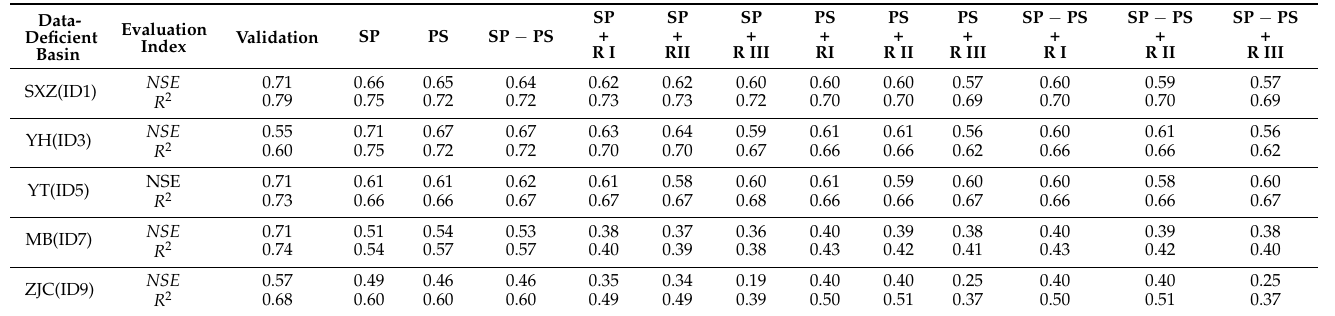
Figure 5. Taylor diagram of the simulated results of 5 target basins. ( a – e ) Present five ungauged basins, respectively. REF is the observed discharge; Ori represents the original simulated results (by auto-calibrating the model); RI, RII, and RIII are the approaches with regression I, regression II, and regression III, respectively. For example, the red triangle means the river discharge simulation results using the SP+RI approach. Table 7. The river discharge simulation results of each regionalized approach in the target